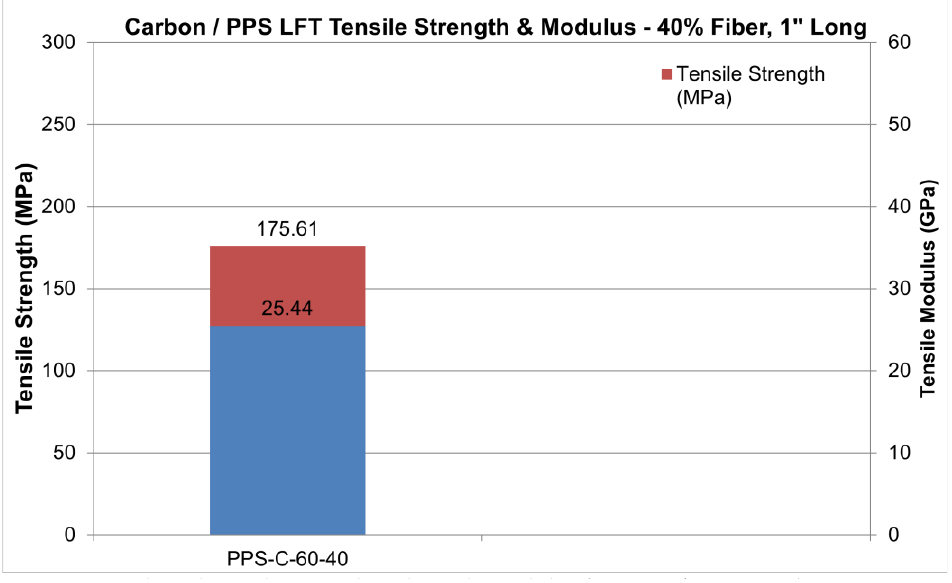
Figure 8. Benchmark tensile strength and tensile modulus for LFT C/PPS 40 wt% CF.